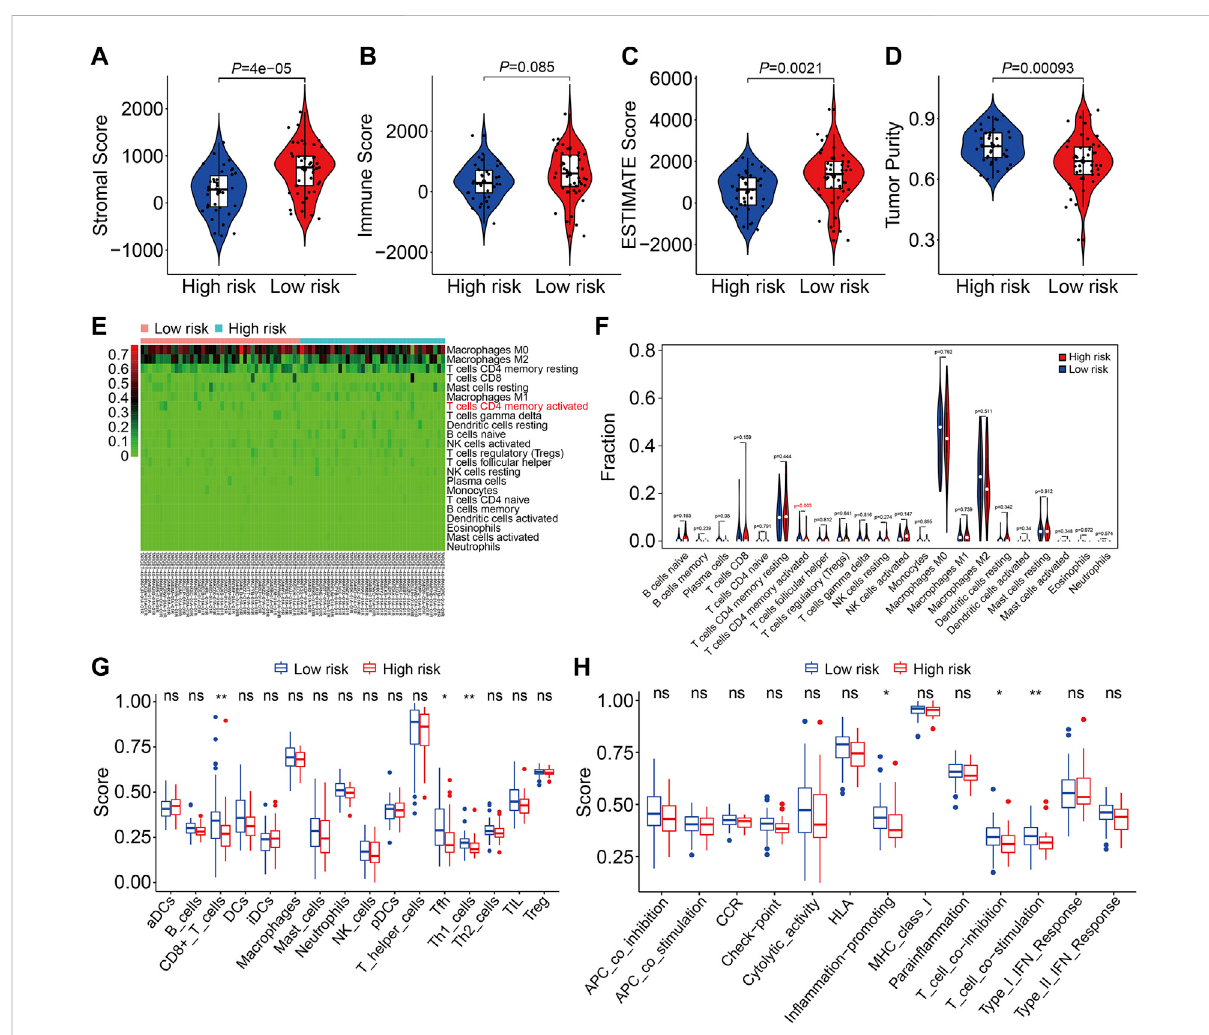
FIGURE 9 Estimation of the immune microenvironment and immune cell in fi ltration in high- and low-risk groups. (A – D) Comparison of the difference in stromal (A) , immune (B) , and ESTIMATE (C) scores, as well as tumor purity (D) , between high- and low-risk groups. (E) Heatmap showing the proportion of 22 immune cell types in TCGA osteosarcoma samples. (F) Comparison of the fraction of in fi ltrated immune cells between high- and low-risk groups. (G,H) Comparison of the scores of immune cells and immune-related function in high- and low-risk